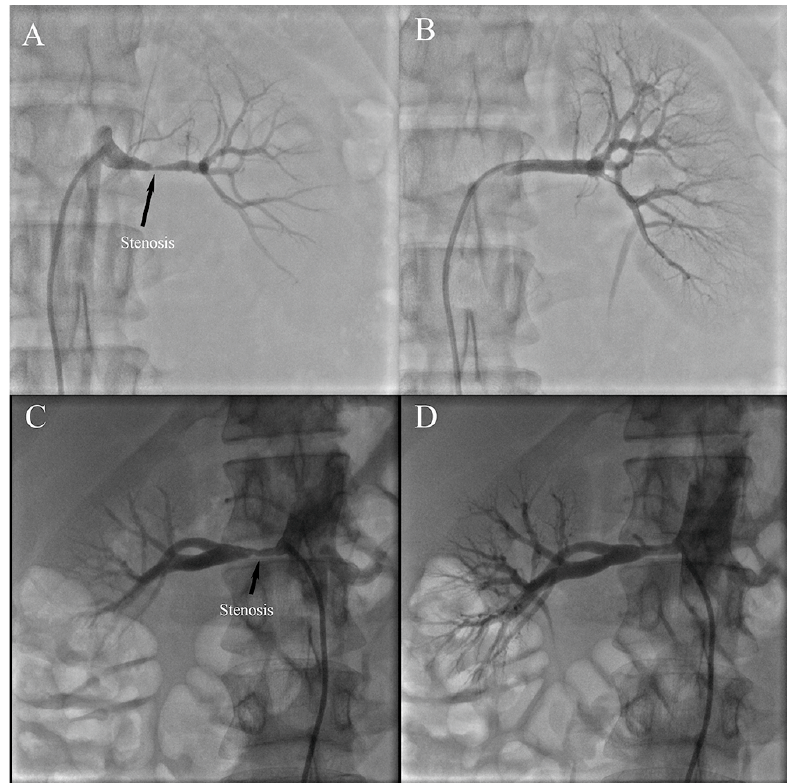
Figure 1. Focal fibromuscular dysplasia includes unifocal-type ( A ) and tubular-type ( B ). ( C , D ) representing vascular stenosis before and after percutaneous transluminal renal angioplasty, respectively. Arrows point to narrowed areas.